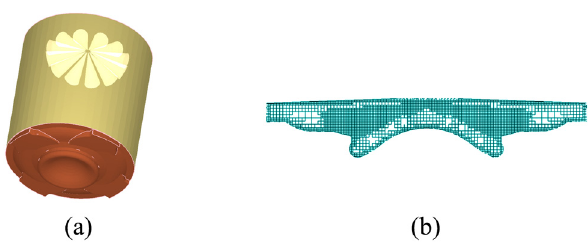
Figure 2: The geometrical model and meshes of the engine. ( a ) The geometrical model and ( b ) the grid structure ( at TDC ) .